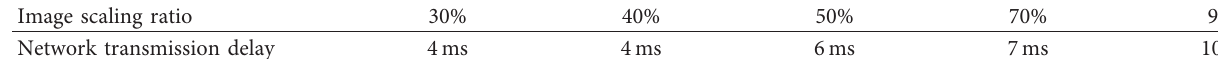
Figure 8: Robustness analysis of the ISDIE algorithm. Table 3: Network transmission delay under different image scaling ratios.